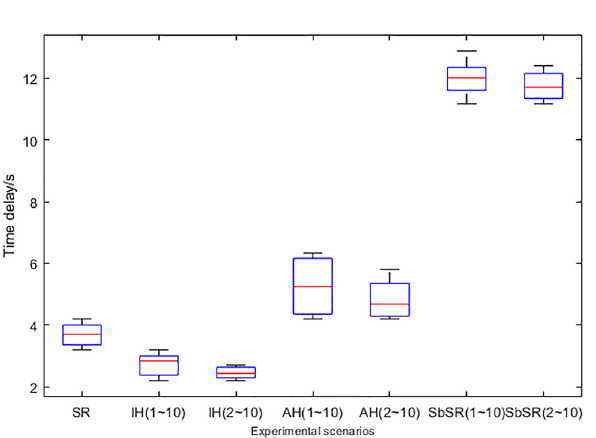
Figure 14. Routing loop attack test.